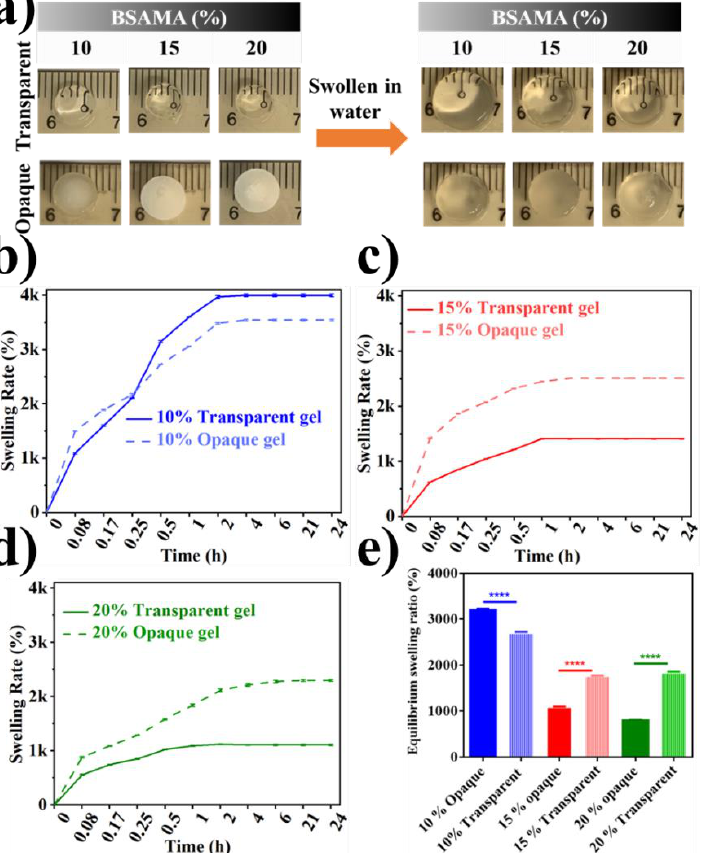
Figure 4. Swelling behavior of the as-prepared transparent and opaque BSAMA gels. ( a ) Digital images of the swelling behavior. ( b – d ) Comparison of swelling rate of BSAMA hydrogels and cryogels (10, 15, and 20% ( w / v )). ( e ) Equilibrium swelling ratio. (Error bars: ± SD, ****= p < 0.0001, n = 3).